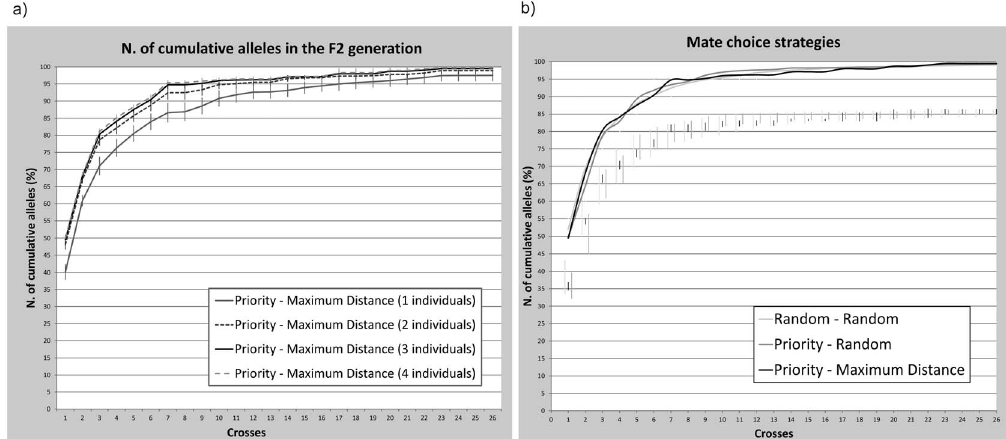
Figure 4. Simulations of allele inheritance under different strategies. Results of the simulations performed using the R-script ‘‘ BreedingPlanSturgeon ’’ to test: (a) the optimal number of breeders per family and (b) alternative strategies for the mating choice. The cumulative percentages of transmitted alleles are averaged on 100 replicates and reported with the corresponding standard deviation. In figure b, 3 individuals per family were crossed and standard deviation bars are shifted downwards for better